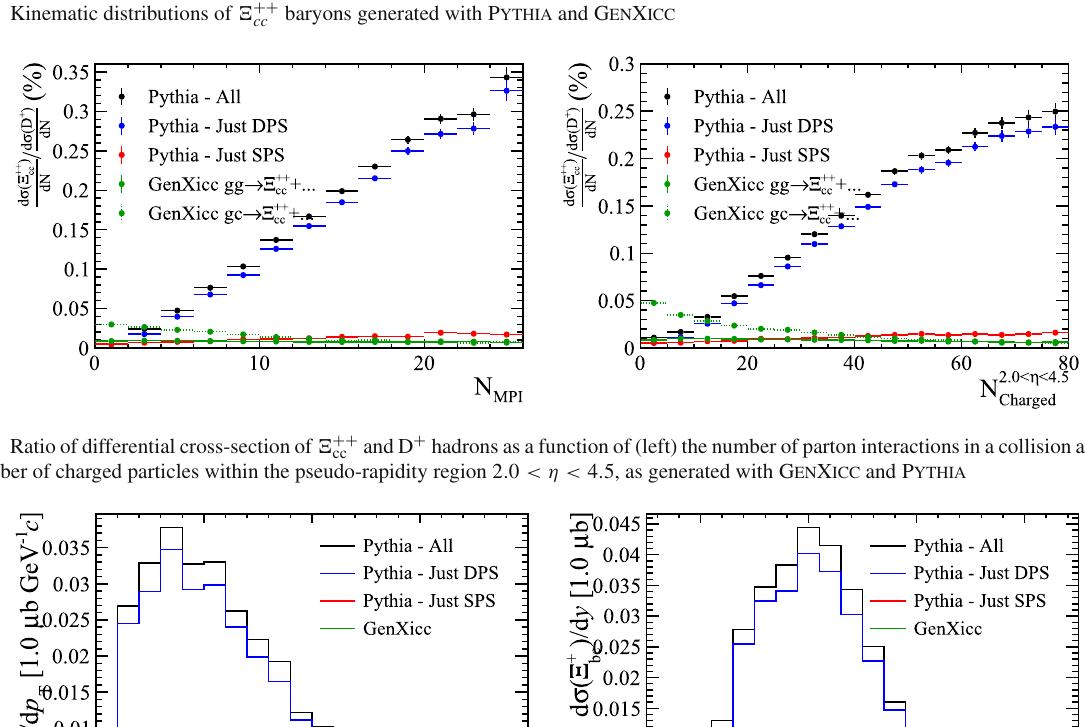
section ratios for the gg → (cid:2) ++